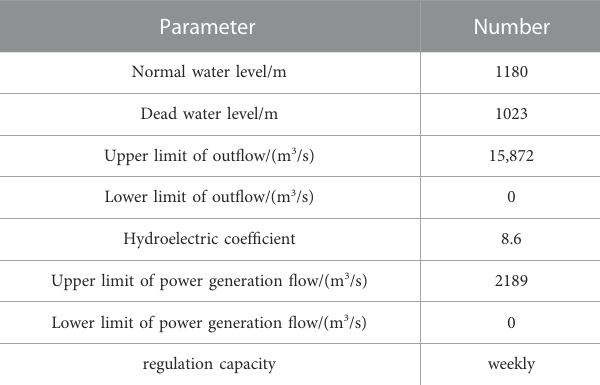
TABLE 1 Main parameters of hydropower